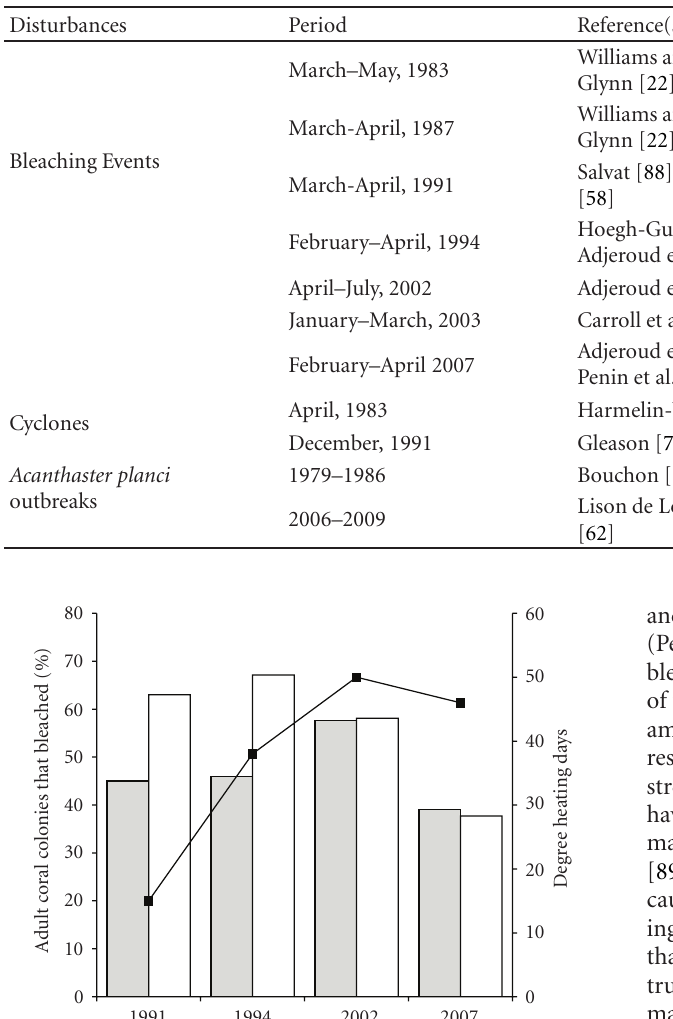
Table 1: Episodic disturbances that have a ff ected Moorea Island, and geometric rate of change in mean coral cover ( Δ Coral cover) reported to occur between successive surveys spanning each disturbance.